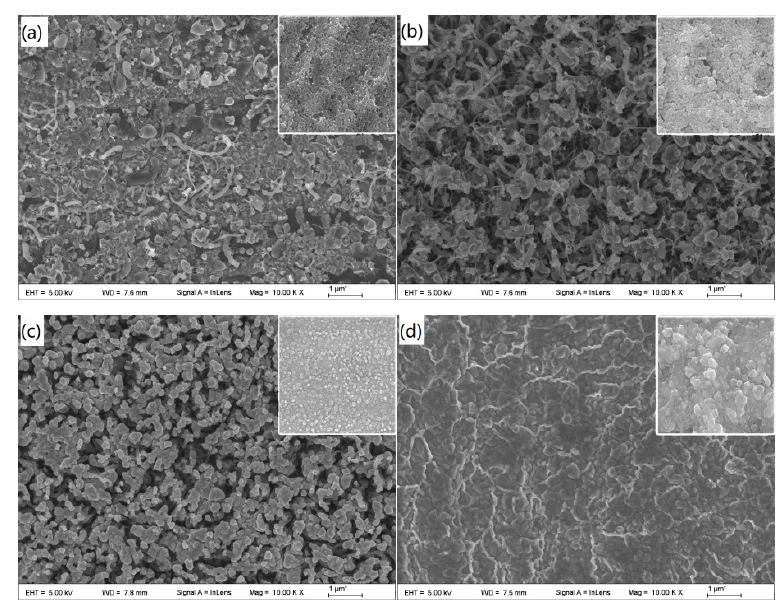
Figure 3. Carbon nanotube morphology on the surface of the sample at different methane ratios: ( a ) Sporadic CNTs grew on the surface of sample A; ( b ) a large number of wound CNTs grew on the surface of sample B; ( c ) vertical CNTs grew on the surface of sample C; ( d ) no CNT growth on the surface of sample D.